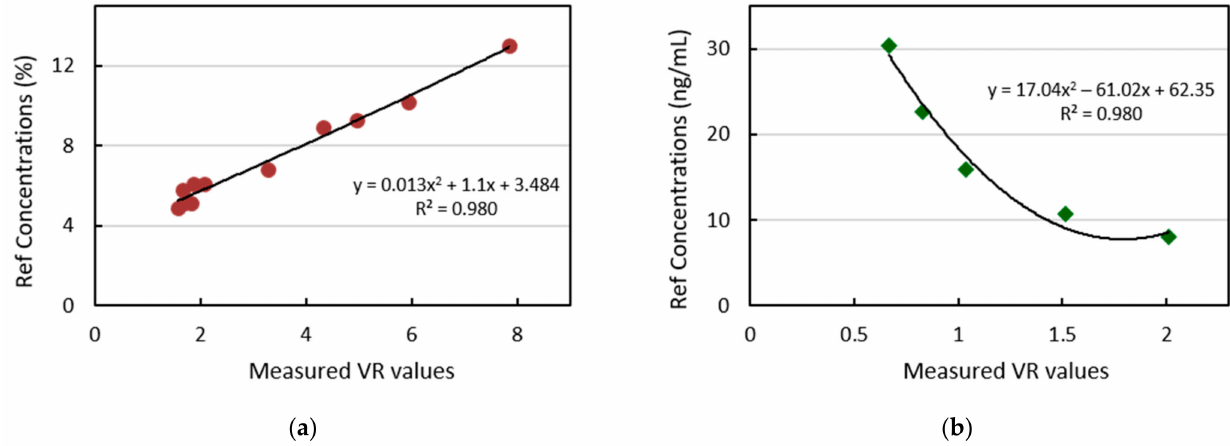
Figure 19. The calibration curve obtained for ( a ) HbA1C test samples with the VR values measured at time t = 12 min ( b ) Vitamin D test samples with the VR values measured at time t = 24 min.